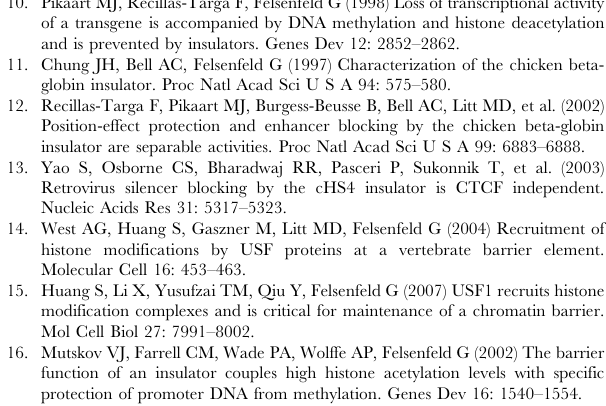
Table S1 VEZF1 sites in the HS4 barrier protect a promoter from DNA methylation. CpG methylation of transgene promoters flanked by wild type or mutant HS4 insulators after 30 or 90 days of culture. The scoring of individual CpG bases from each clone subject to bisulfite sequencing is shown. Methylated bases are marked as ‘1’ and shaded blue. Average CpG methylation values are shown in Figure 5. Numbers above each table refer to CpG numbering from [16], where CpG 4–11 and 12–18 reside in the promoter and coding sequence, respectively. Table S2 Mutations of insulator protein binding sites result in the de novo methylation of HS4. CpG methylation of wild type (WT) or mutant ( D I - D V) HS4 insulators after 30 or 90 days of culture. Both copies of HS4 were sequenced, except for D II and D V, where only the outermost copy was sequenced (see Materials and Methods). The scoring of individual CpG bases from each clone subject to bisulfite sequencing is shown. Methylated bases are marked as ‘1’ and shaded blue. Average CpG methylation values are shown in Figure 3. Numbers above each table refer to CpG numbering as assigned in Figure